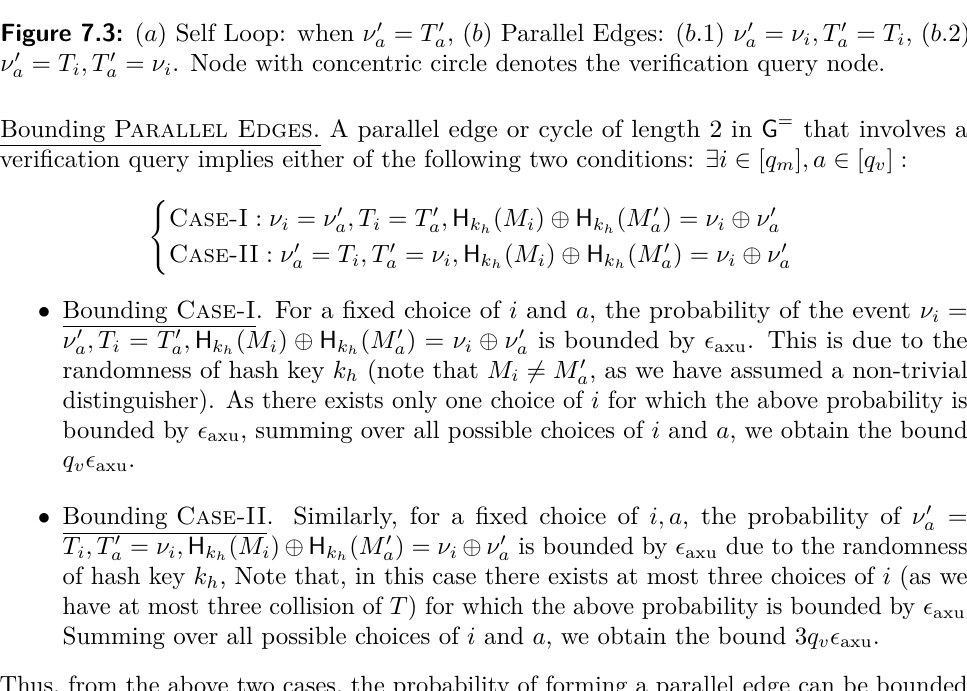
= ν i , T 0 = T i , ( b. 2) a a